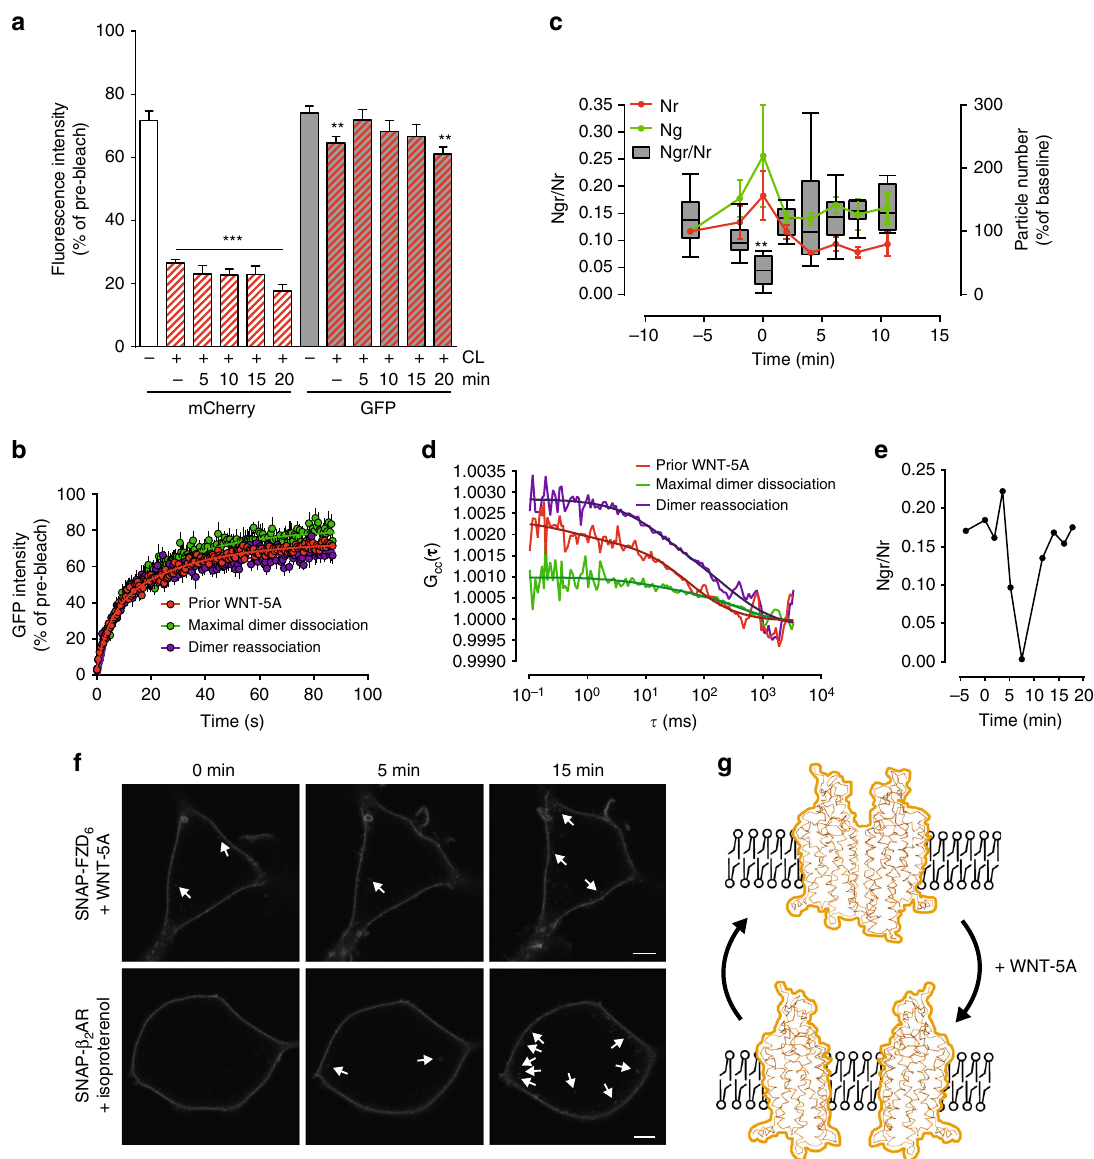
Fig. 5 Agonist-dependent dynamics of FZD 6 dimerization. a dcFRAP in HEK293 cells expressing V5-FZD 6 -mCherry and FZD 6 -GFP allowed kinetic monitoring of receptor – receptor interactions in the absence of agonist and after 5, 10, 15, 20 min of WNT-5A (300 ng ml − 1 ) stimulation. P = 0.0219; F (5, 109) = 2.757. Before CL (20 ROIs); after CL (unstimulated = 38 ROIs, 5 min = 12 ROIs, 10 min = 18 ROIs, 15 min = 12 ROIs, 20 min = 15 ROIs). N = 10. Unstimulated (before and after CL) are from Fig. 1d and were performed in parallel with stimulation experiments. b Curves depict the recovery of GFP after CL comparing unstimulated ( red ), 5 min ( green ) and 20 min ( magenta ) after WNT-5A stimulation. c Dynamic FCCS experiments in HEK293 cells expressing V5-FZD 6 -mCherry and FZD 6 -GFP from 6 different cells are summarized by normalizing the agonist-induced minimum fraction of dimers from individual cells to 0 min ( N gr / N r represents ratio of FZD 6 -GFP/V5-FZD 6 -mCherry dimers ( green / red , gr) over the total number of red molecules ( red , r), representing the fraction of dimers present in the detection volume). Box plot presents data from the 25 to 75th percentile and whiskers provide min/max. P = 0.0093; F (7, 39) = 3.178. ** P < 0.01 (one-way ANOVA, Fisher ’ s LSD post hoc analysis). Total number of N r ( red ) and N g ( green ) particles in the detection volume over time. Values of N r or N g at the fi rst time point were set to 100. d FCCS curves present cross-correlation of V5-FZD 6 -mCherry and FZD 6 -GFP from a representative cell prior to WNT-5A stimulation ( red ), at maximal dimer dissociation ( green ) and upon dimer re-association ( magenta ). When normalized to the green auto-correlation amplitude, the amplitudes of the three G cc curves revealed that 11, 6, and 21% of red molecules were also green , respectively. e Representative example of N gr / N r after WNT-5A stimulation for a cell expressing wt FZD 6 -GFP and wt FZD 6 -mCherry. t = 0 refers to fi rst measurement after the addition of WNT-5A. f HEK293 cells expressing SNAP-FZD β 6 or SNAP- 2 -AR were pulsed with a cell-impermeable SNAP substrate to monitor internalization after WNT-5A (300 ng ml − 1 , 15 min) or isoproterenol (10 µ M). Arrows indicate internalized receptors. Scale bar = 5